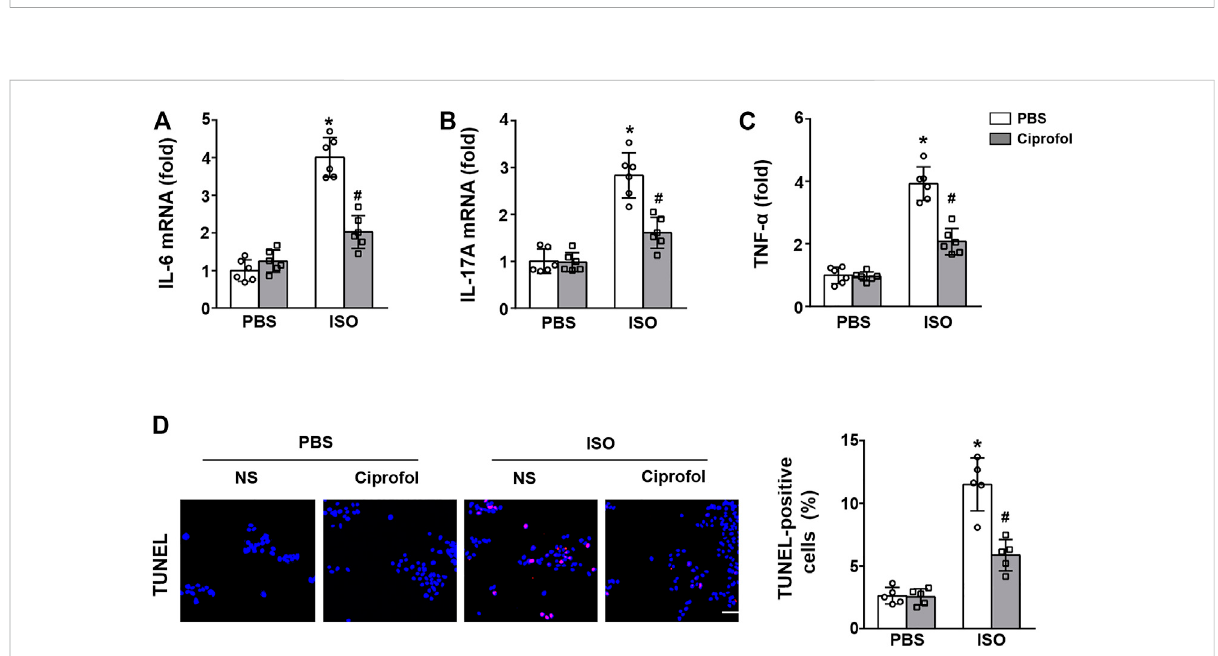
FIGURE 7 Ciprofol treatmentblunted ISO-induced in fl ammation and cardiomyocyte apoptosis in vitro . The mRNA levels of IL-6 (A) , IL-17A (B) and TNF- α (C) were measured ( n = 6). (D) Representative images of TUNEL staining in each group ( n = 5). p p < 0.05 compared to the PBS group. # p < 0.05 compared to the ISO